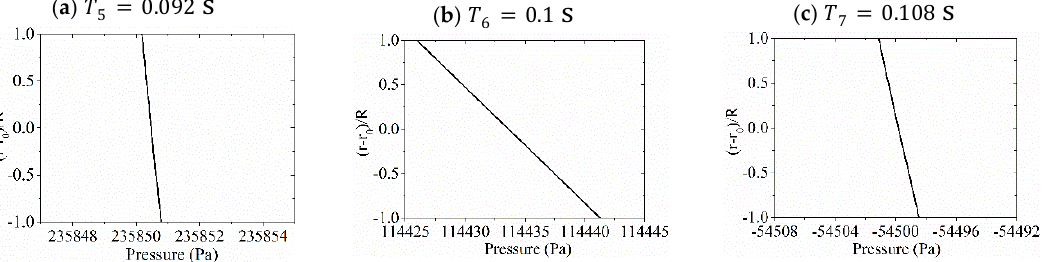
Figure 17. Local pressure distribution at S1 monitoring position of different time ( 𝑇 5 = 0.092 s , 𝑇 6 = 0.1 s , and 𝑇 7 = 0.108 s ).